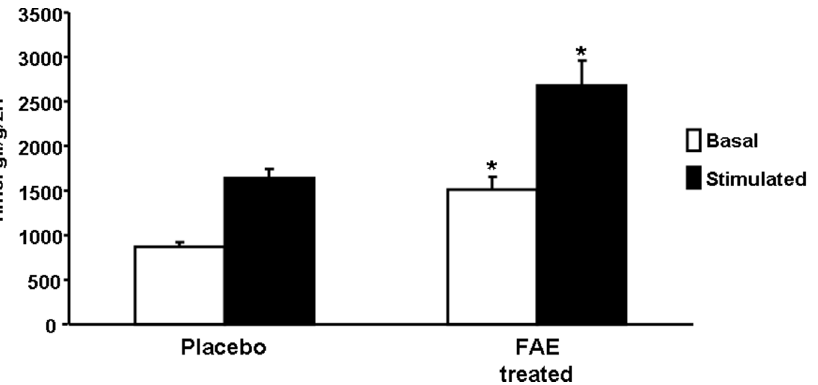
Figure 2. Basal and insulin stimulated lipogenesis in SHR-CRP transgenic rats treated with fumaric acid esters (FAE) (N=6) or placebo (N=7). FAE treated SHR-CRP transgenic rats showed significantly greater levels of both basal (open bars) and insulin stimulated (solid bars) incorporation of radioactively labeled glucose into adipose tissue lipids when compared to untreated rats. *denotes significant difference compared to untreated controls, P , 0.01.